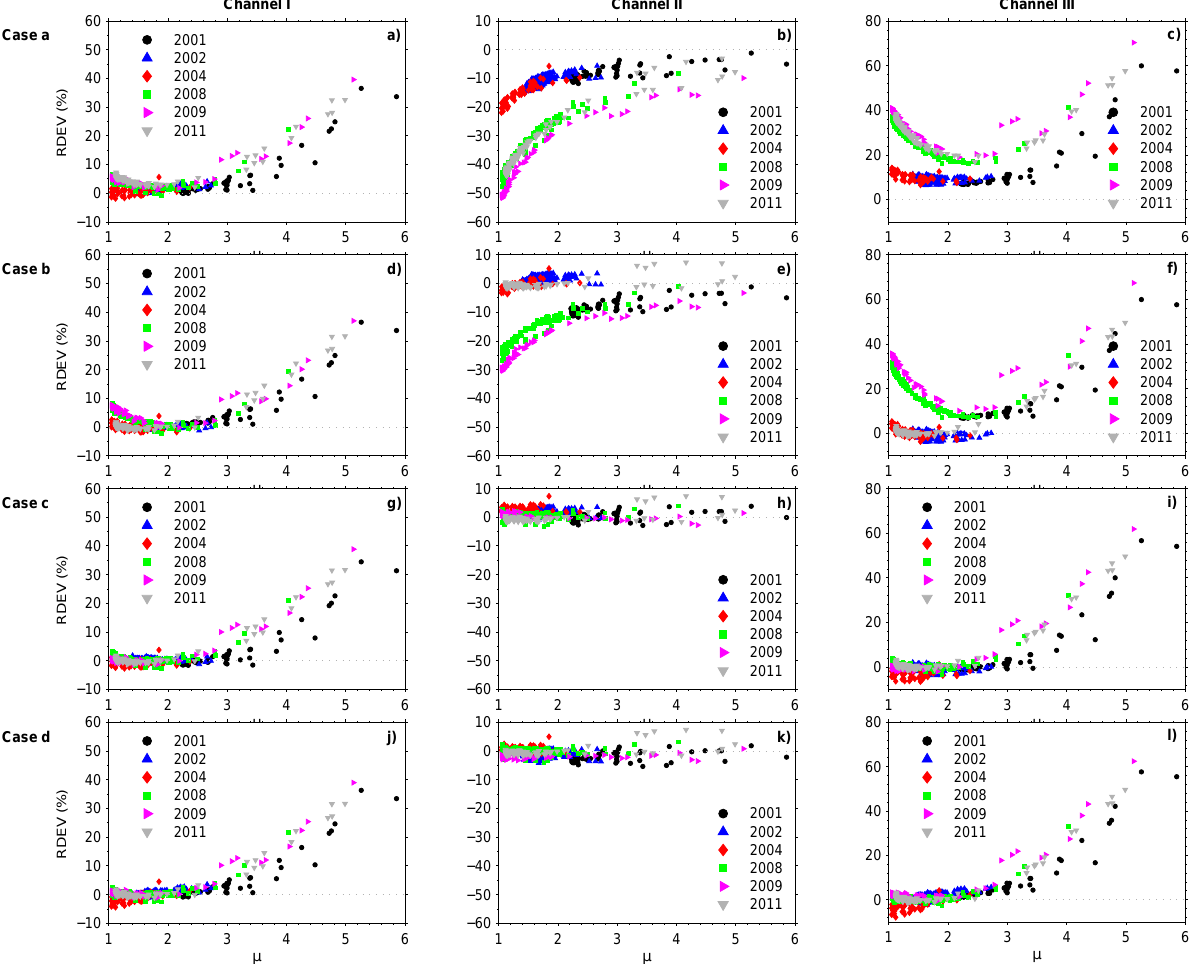
Fig. 4. Evolution of the relative deviation between Brewer and Microtops II ozone for the different calibration tests versus the airmass for the three retrievals. Case a, using the original calibration from 1997; Case b, using a step by step calibration; Case c, using linear interpolation with time between the calibrations; and Case d, using a linear interpolation between calibrations made in 1997 and